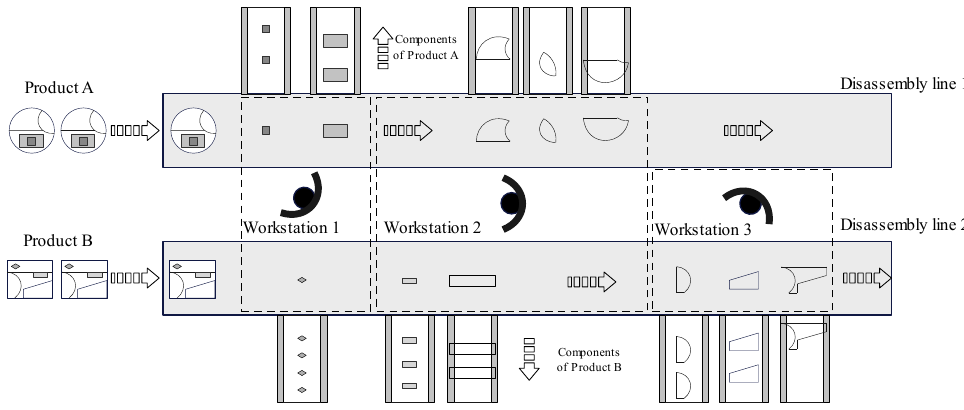
Figure 2. Parallel disassembly